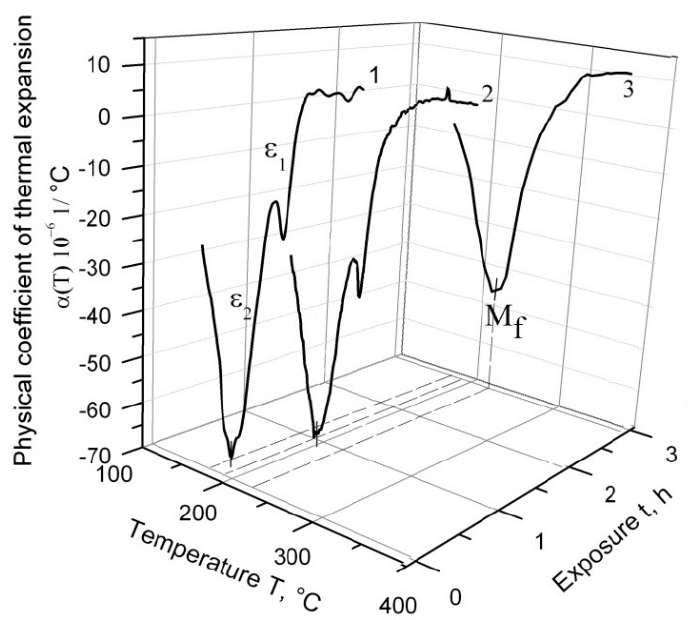
Figure 3. The influence of exposure at the high-heat region on the effect of martensitic peak splitting: 1—without exposure, 2—1 h exposure, and 3—3 h.